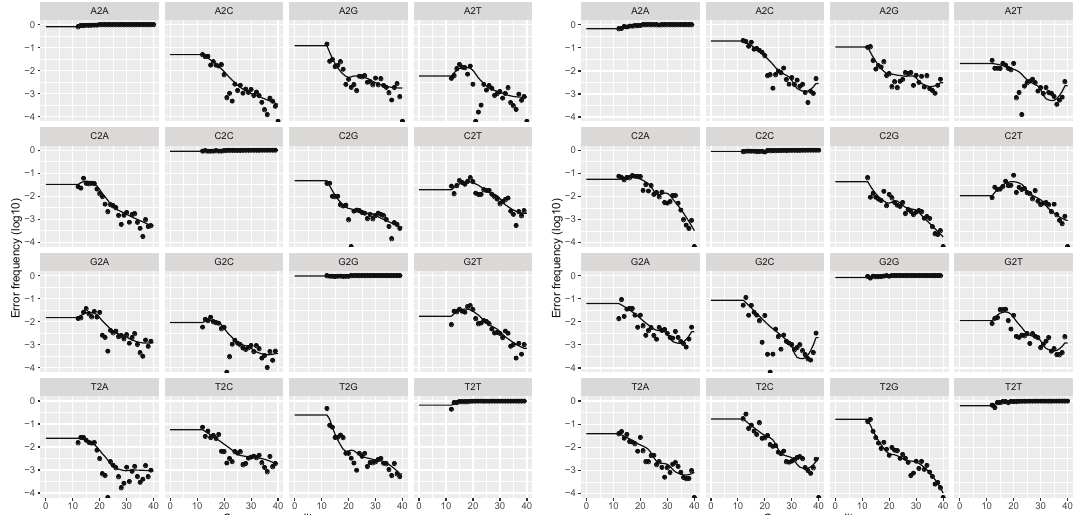
Figure 2. Forward and Reverse Read Error Profiles, showing the frequencies of each type of nucleotide transition as a function of